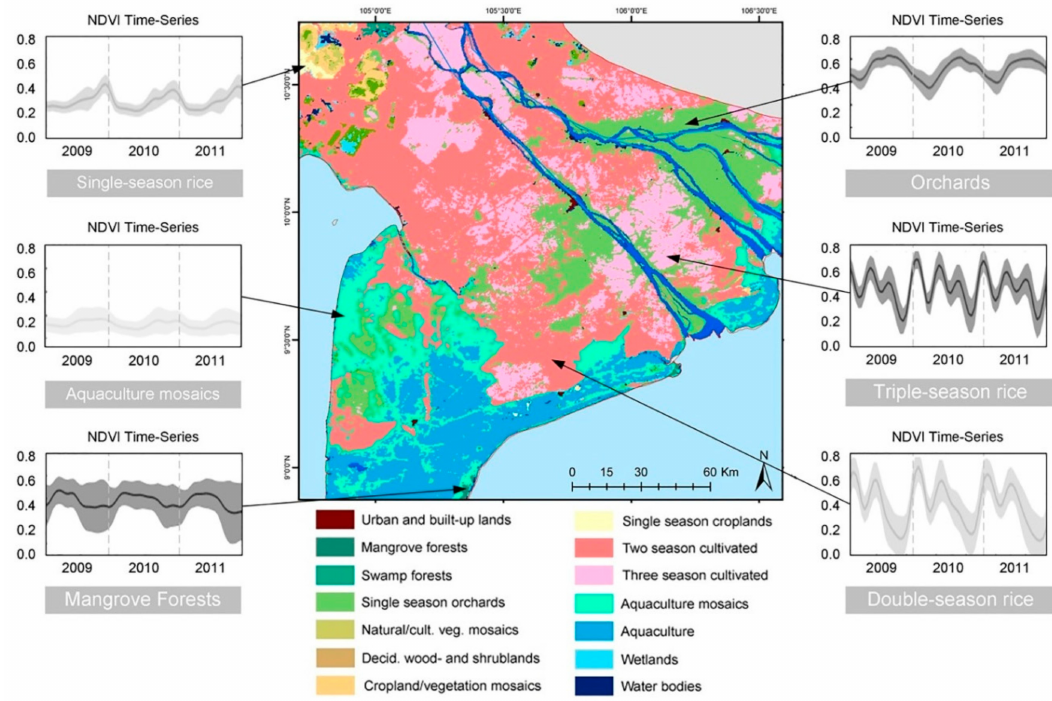
Figure 14. The temporal, intra-annual signature “fingerprint” of surfaces. Excerpt of a Mekong Basin land use classification based on an intra-annual MODIS Enhanced Vegetation Index, EVI time series for 2010. Despite the low spatial resolution of 500 m, twelve land use classes can be extracted for the Mekong Delta